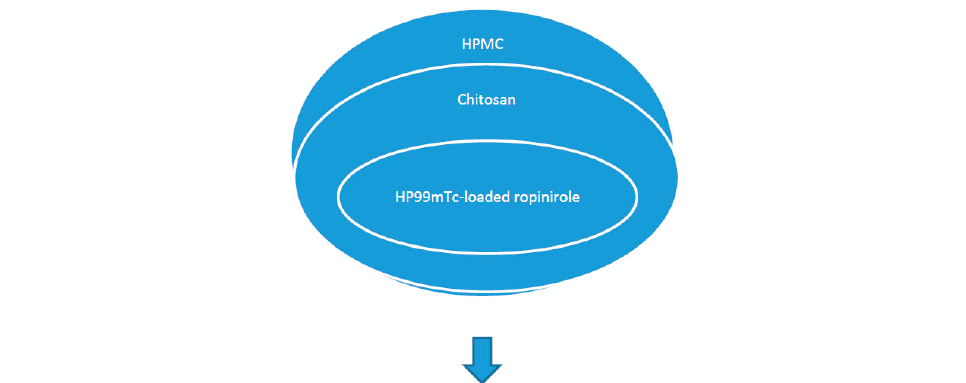
Figure 3. Chitosan-based in situ gels for the delivery of ropinirole.